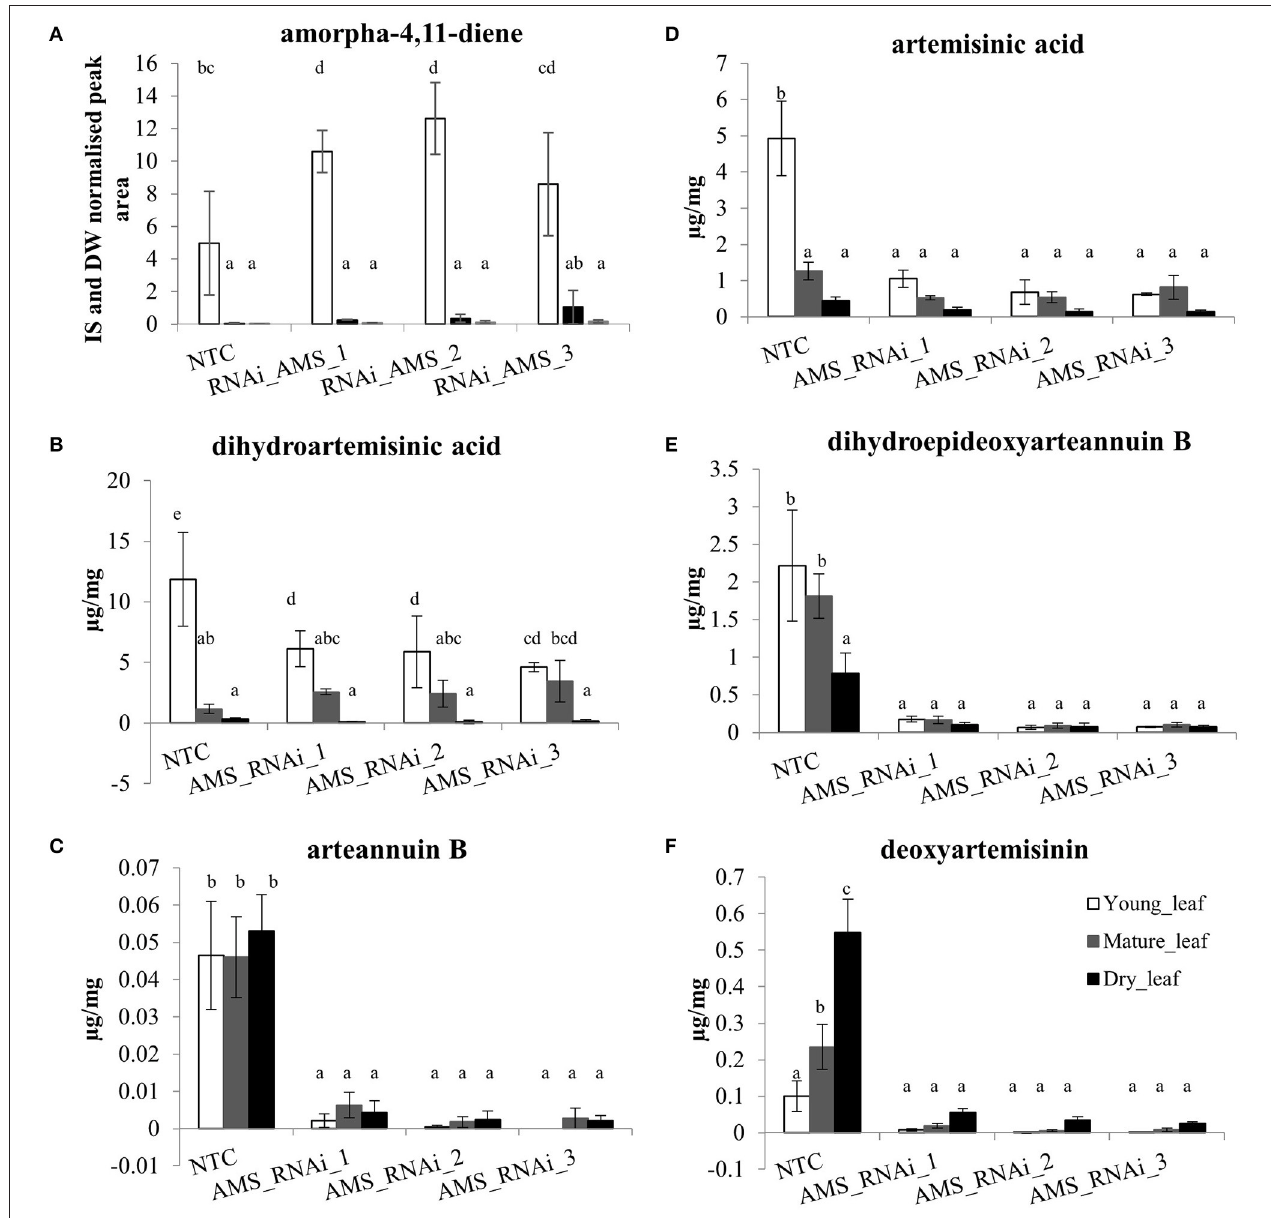
FIGURE 4 | The concentration ( µ g/mg extracted dry weight) of known artemisinin pathway compounds in young leaves, mature leaves and dried pooled leaf material for NTC and AMS _RNAi lines. (A) amorpha-4,11-diene, (B) artemisinic acid, (C) dihydroartemisinic acid, (D) dihydroepideoxyarteannuin B, (E) arteannuin B,